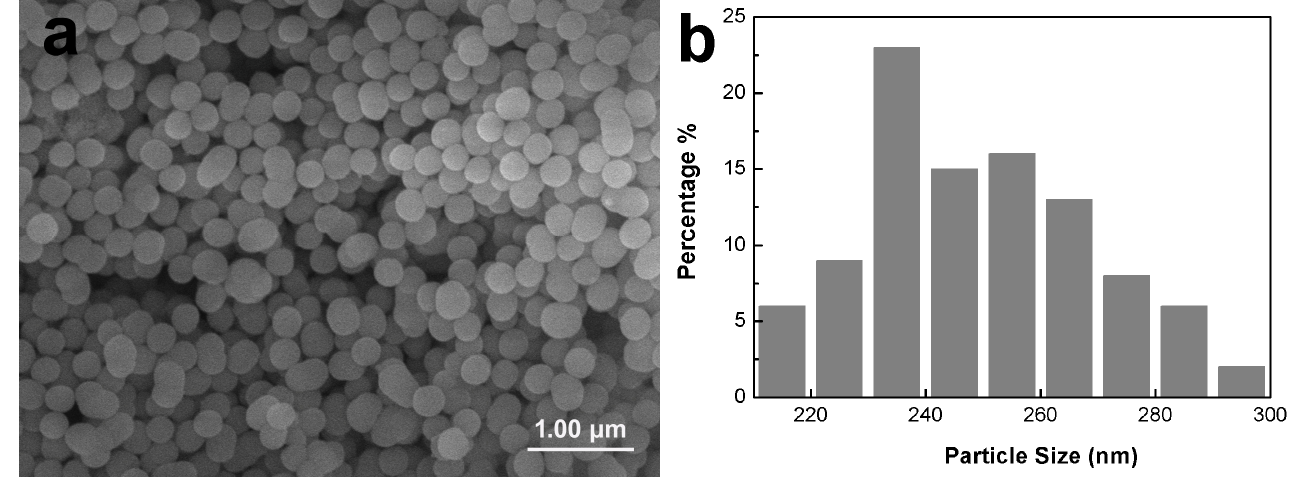
Figure 2. Morphology ( a ) and particle size distribution ( b ) of MBG nanospheres fabricated by sol– gel.